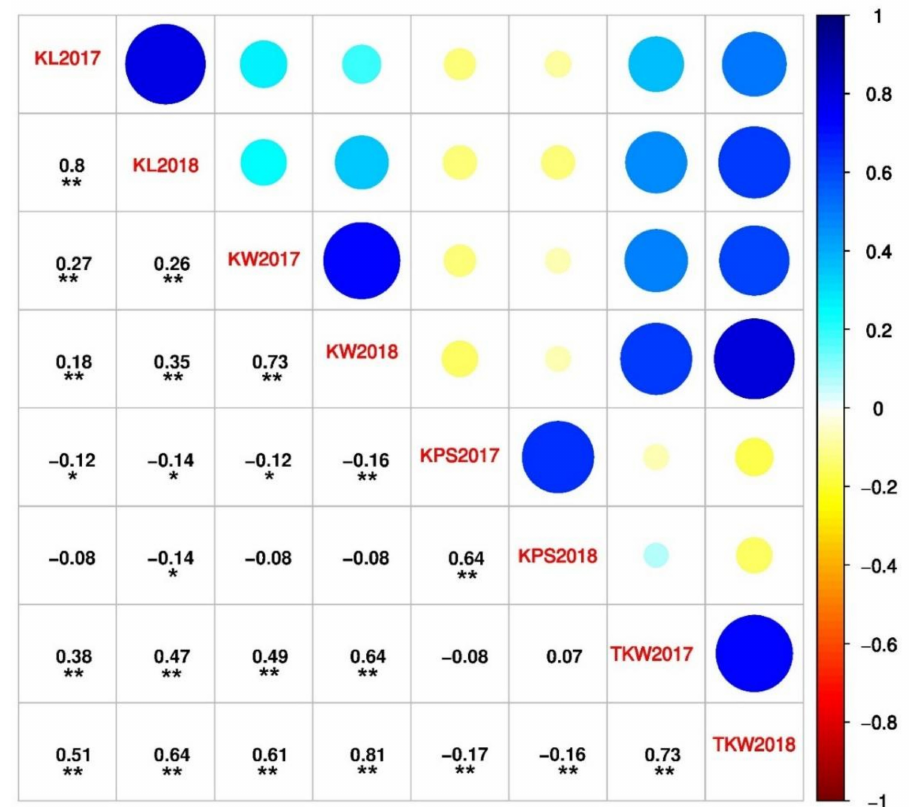
Figure 2. Correlation between the kernel traits, including KL (kernel length), KW (kernel width), KPS (kernels per spike), and TKW (thousand kernel weight) for 2017 and 2018. Significant correlations are shown with asterisk (*). * and **, significant at p < 0.05 and p < 0.01,